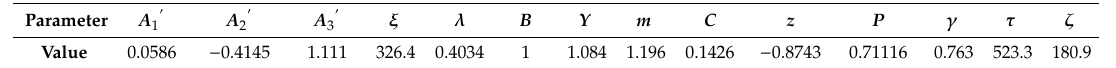
Table 9. Parameters of the constitutive